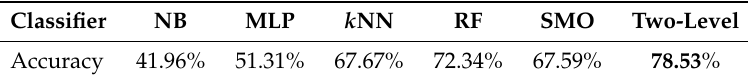
Table 8. Performance of each individual